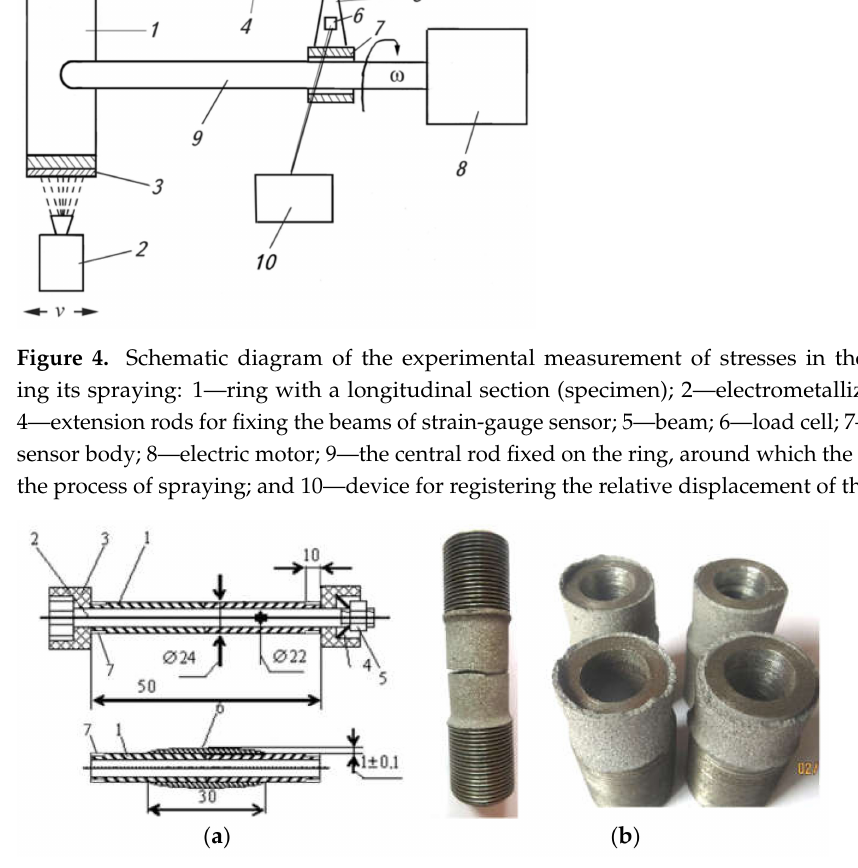
Figure 5. Scheme of the device for applying ASC to the surface of the assembled specimen and the specimen, released from the mandrel, ready for stretching until the coating breaks and determining its cohesive strength ( a ): 1—two parts of the specimen; 2—bolt; 3—guide washers; 4—spring; 5—nut; 6—coating; 7—thread for tensile grips; and ( b ) failed specimens after tests for cohesive